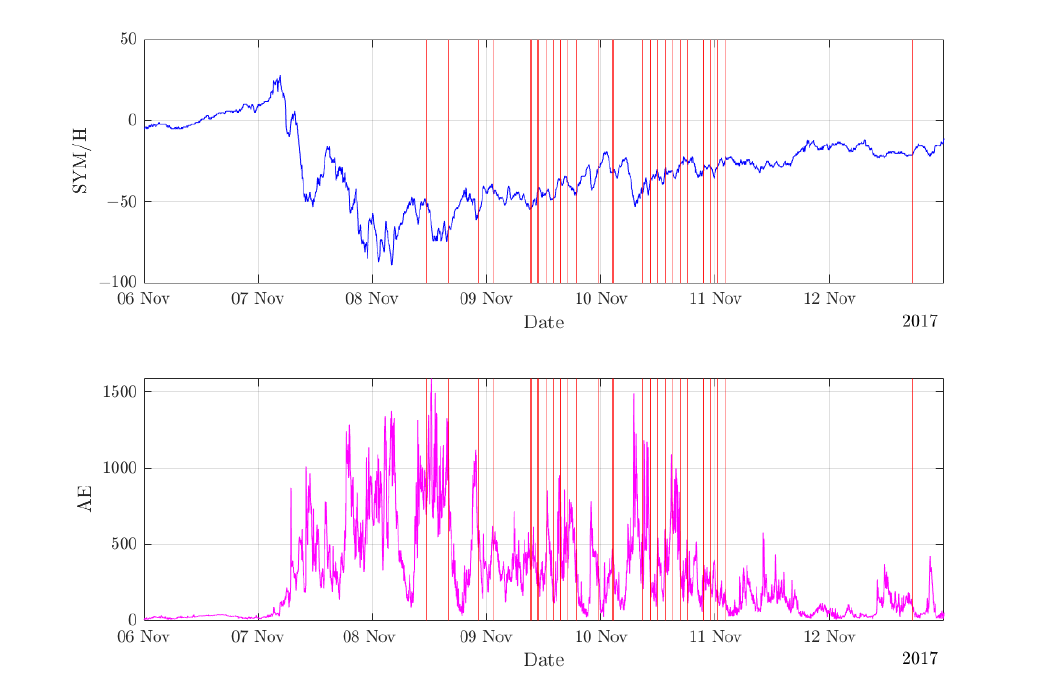
Figure 4. Geomagnetic activity during November 2017. The upper plot demonstrates SYM/H index behavior, lower